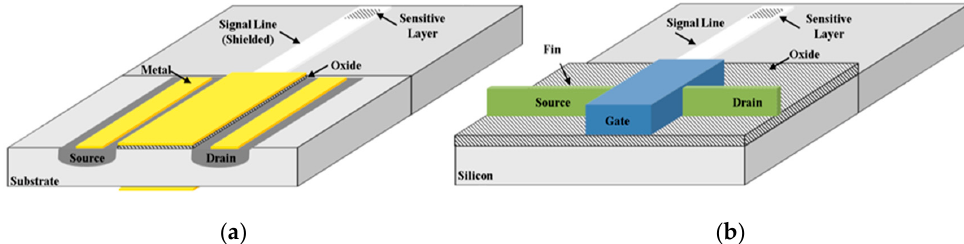
Figure 1. Representative view of a device based on extended gate field effect transistor (EGFET) ( a ) and ( b ) fin field ‐ effect transistor (Fin ‐ FET) technology (not in scale).